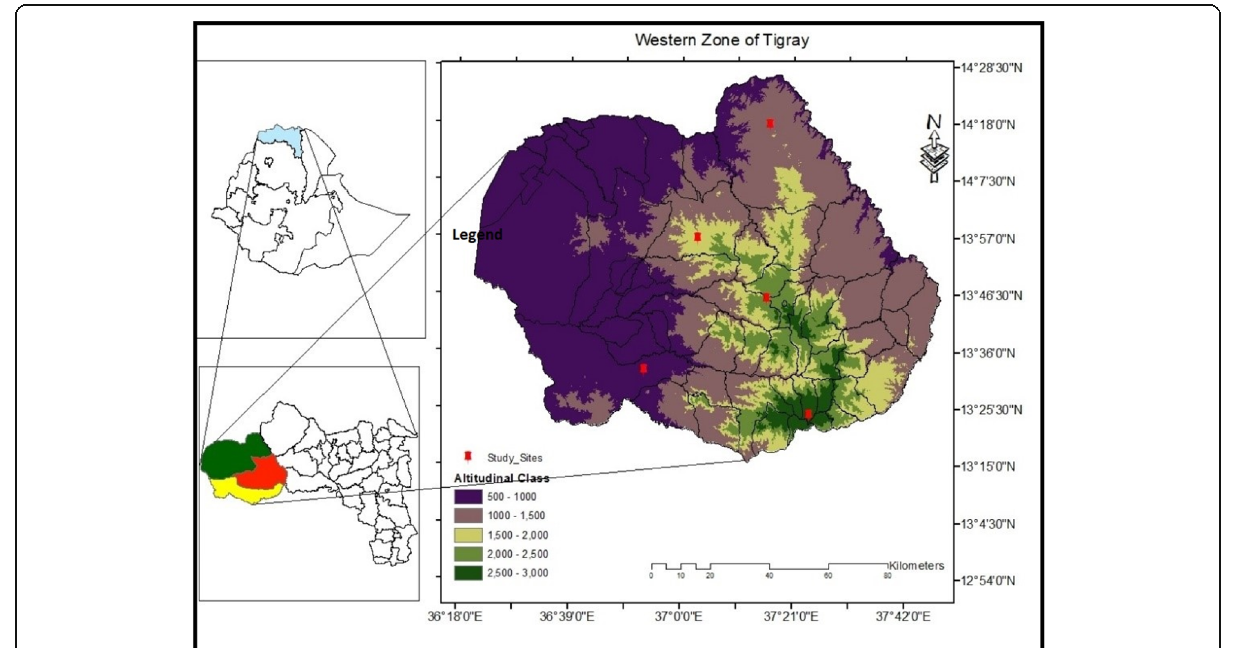
Fig. 1 Map of altitudinal classifications of the Western Zone of Tigray, Northern